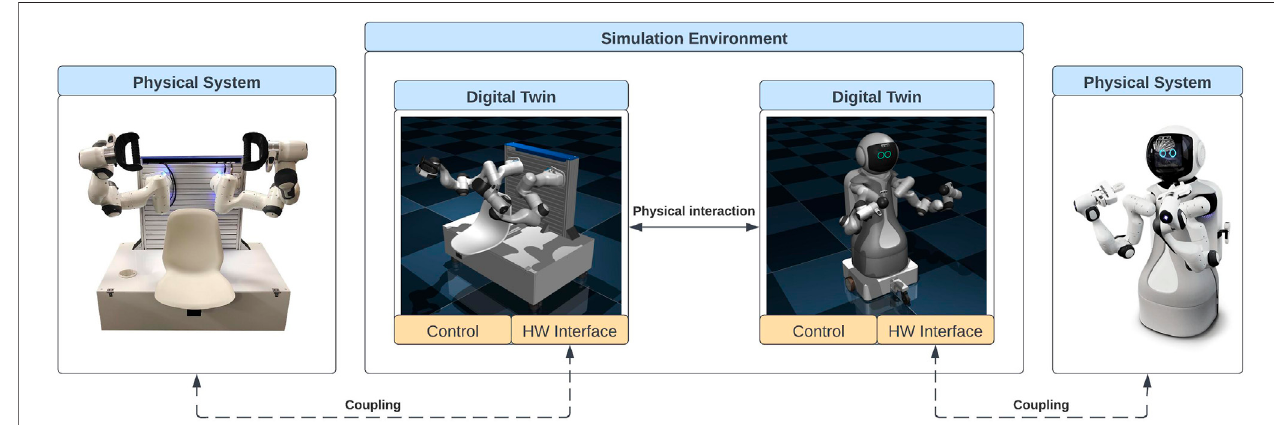
FIGURE 1 | System overview of our model-mediated approach to robot control. The simulation environment is populated with digital twins that may interact with eachotherandtheenvironment.Hardwareinterfacesallowfortransparentcouplingofthedigitaltwintoitsrealworldcounterparttoclosethecontrolloopinthephysical